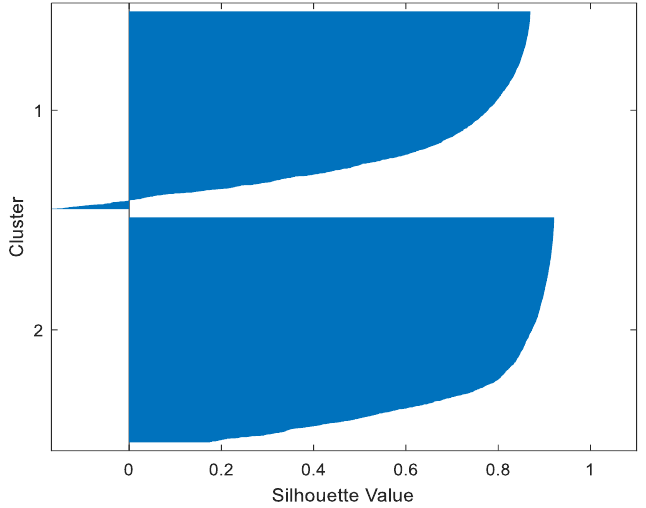
Figure 12. Abalone FP-Conv-CM.